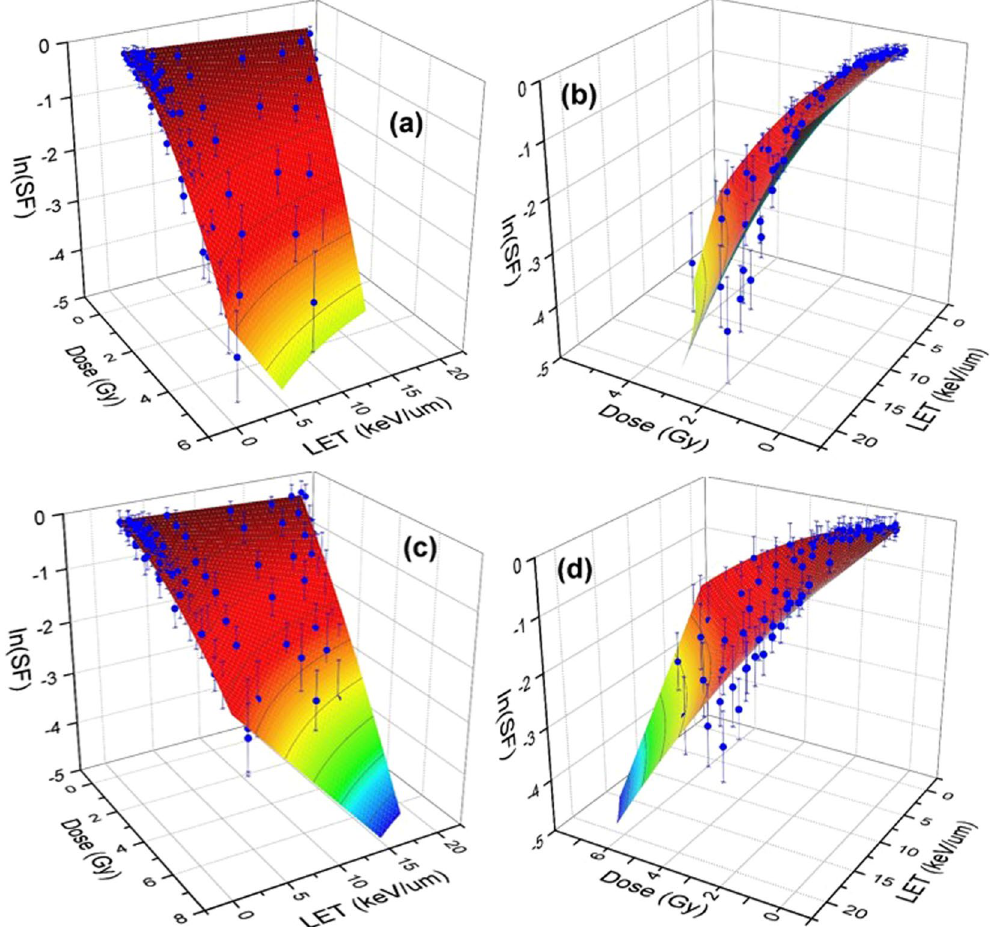
Figure 4. Shown same experimental data of clonogenic survival fraction (SF) for H460 ( a , b ) and H1437 ( c and d ) cells as in Fig. 3 with a difference that a linear LET model corresponding to α = α 0 + α 1 L and β = β 0 have been used to obtain a globally optimal surface fitted to the experimental data. Similar to Fig. 3, the left and right figures show the views from low and high